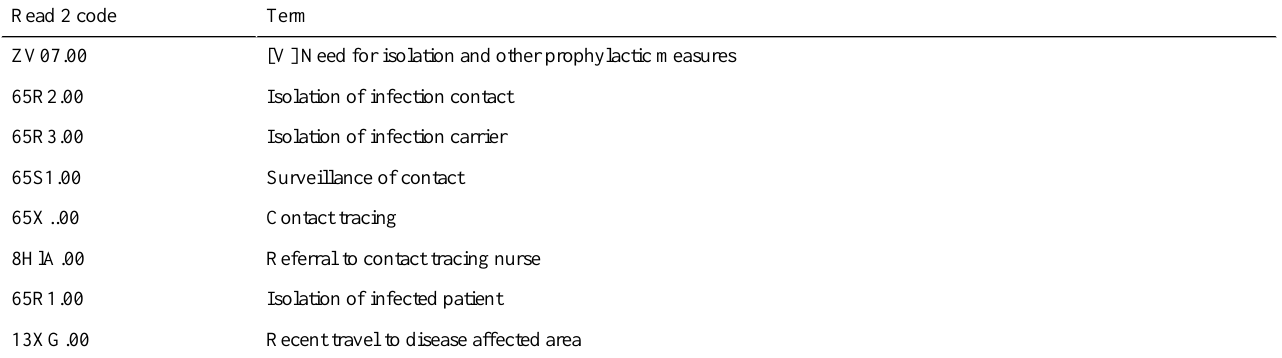
Table 2. Read 2 codes to flag control measures and audit their